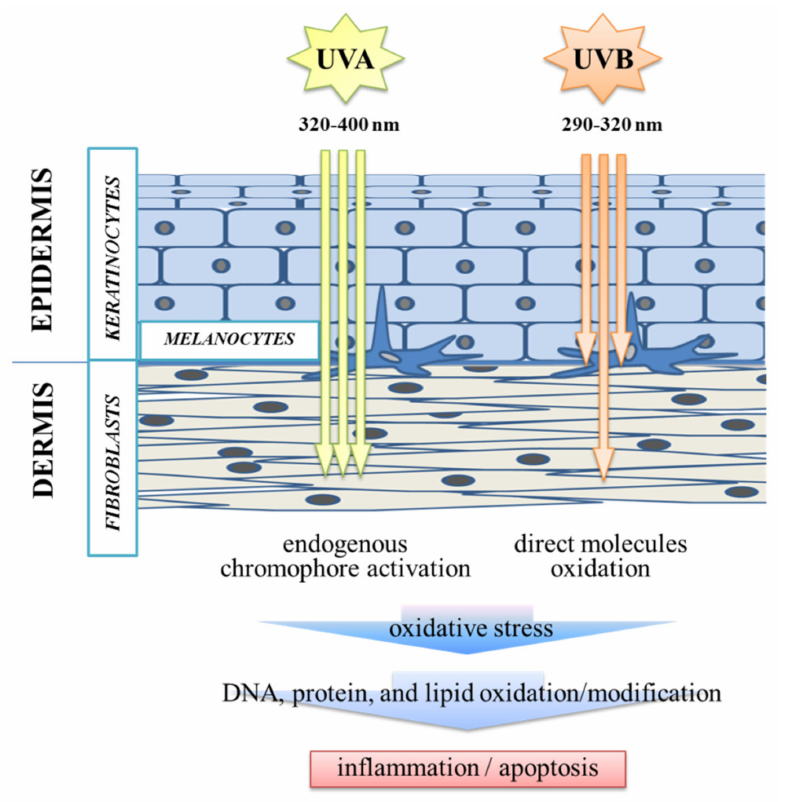
Figure 1. The comparison of the penetration and effects of UVA (320–400 nm) and UVB (290–320 nm) radiation in relation to cells of different skin